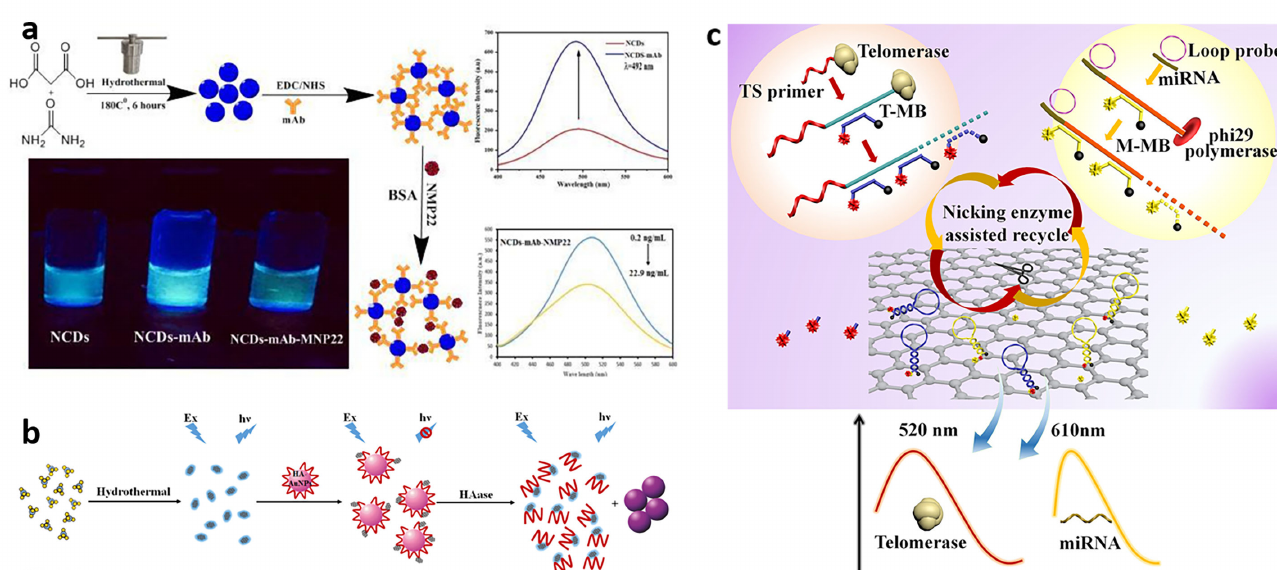
Figure 5. ( a ) Schematic for the detection principle of NMP22 with carbon dots. (Reprinted with permission Ref. [55]. Copyright © 2020 Elsevier B.V.) ( b ) Schematic of the synthesis of MoS 2 QDs and HAase detection. (Reprinted with permission Ref. [56]. Copyright © 2016 American Chemical Society.) ( c ) Schematic of the binary assay for miRNA and telomerase. (Reprinted with